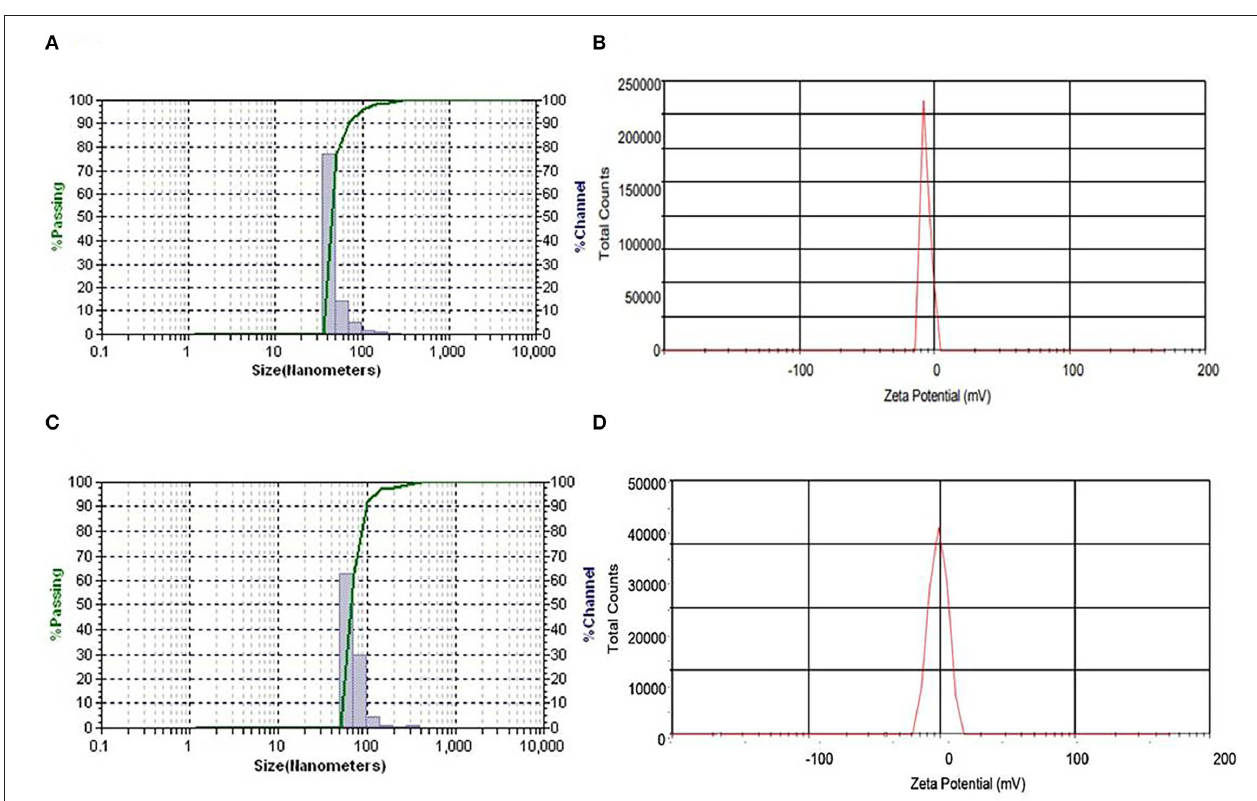
saponin, was effectively used to stabilize the developed NEs at 0.5%